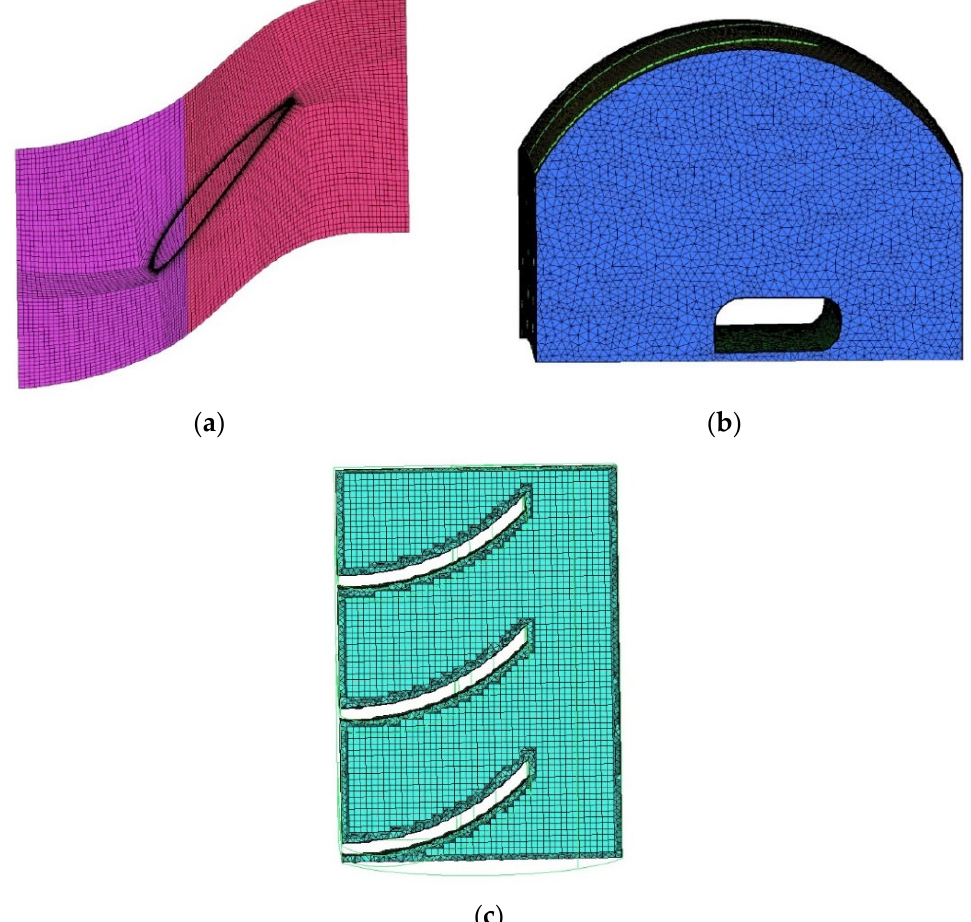
Figure 6. Computational grids for ( a ) rotor blade, ( b ) casing treatment front view, and ( c ) casing treatment top view. Table 13. Effect of mesh size on time-averaged pressure and mesh